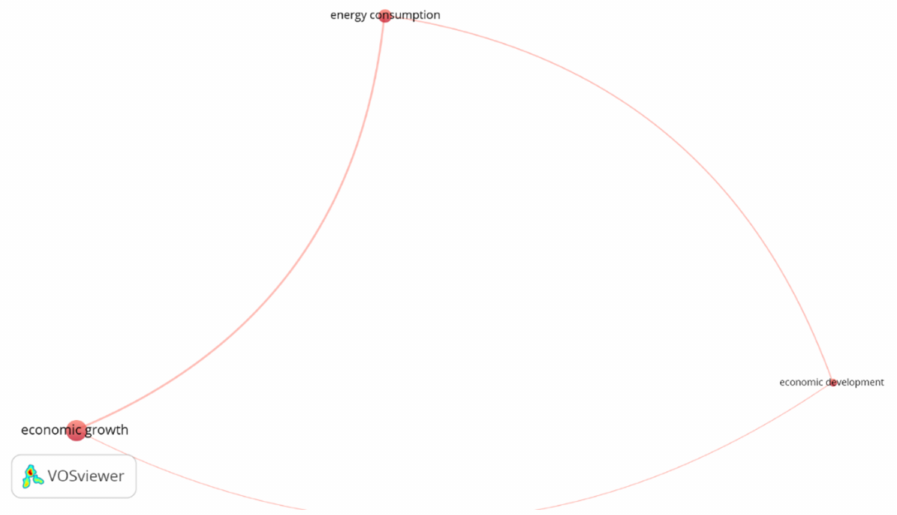
Figure 8. Link Between Energy Consumption, Economic Growth and Development Economic.